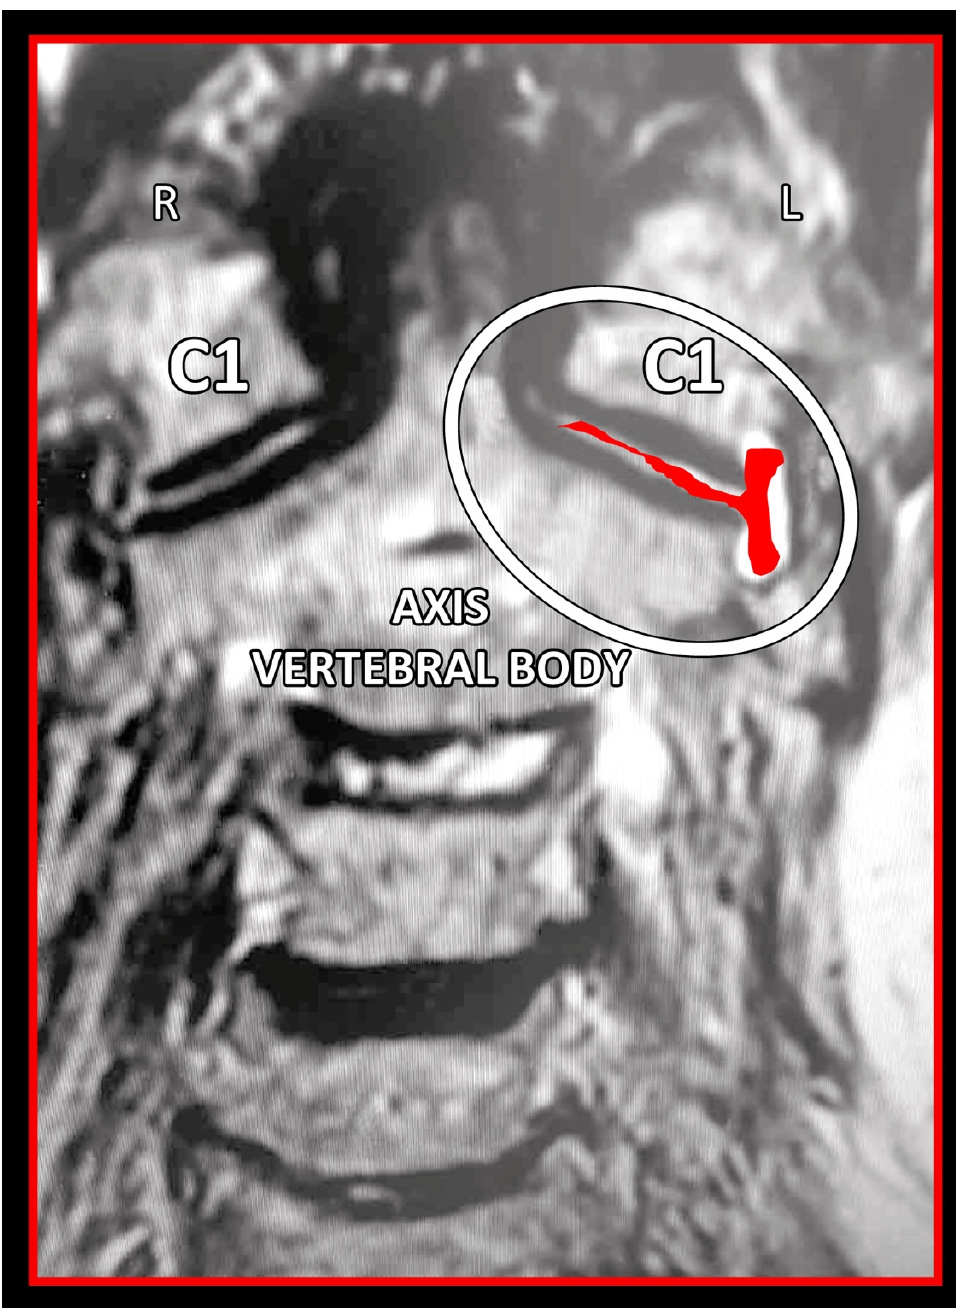
Figure 18. Atlas - axis synovitis. Magnetic resonance imaging showing the left lateral effusion of atlas - axis intra-joint passive congestion, with increased pain during active axial rotation of the atlas on axis to either side. C 2 nerve root involvement with unilateral hemicranial pain.